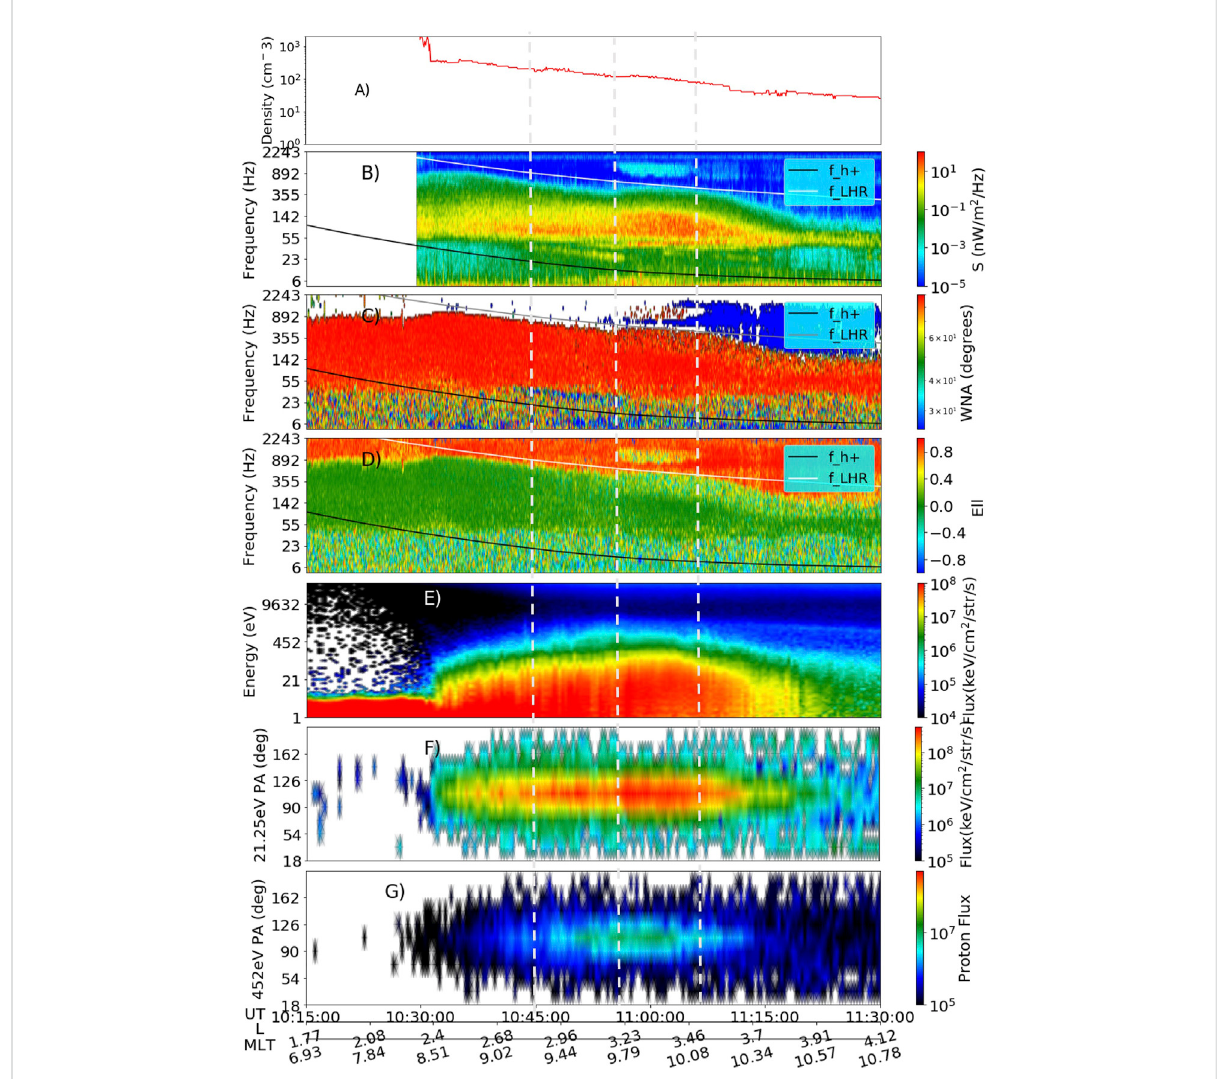
FIGURE 2 Correlation betweenthermalandsuprathermal protonpancakepitchangle distributions(PADs) andthemagnetosonic(MS)wavesobservedby Van Allen Probe A on 8 September 2017. Panel (A) shows the electron density pro fi le. Panel (B) shows the Poynting fl ux density, panel (C) shows the wave normal angle, and panel (D) shows theellipticityof themagnetic fi eld polarization,inthe frequency range from 5to 2000 Hz. Inpanels (B) , (C) , and (D) , the white and the black traces represent lower hybrid resonance frequency and proton cyclotron frequency, respectively. Electron densitydataandsheathcorrectedPoyntingvectordata(showninpanelsAandB)arenotavailablebetween10:15and10:30UT.Energyspectrogram ofspin-averagedproton fl uxisshowninpanel (E) .Pitchangledistributionsofproton fl uxesatenergiesof~21 eVand~450 eVareshowninpanels (F) and (G) respectively. The vertical white dashed lines mark the time intervals with different MS wave intensity, subsections of which are used for quasilinear